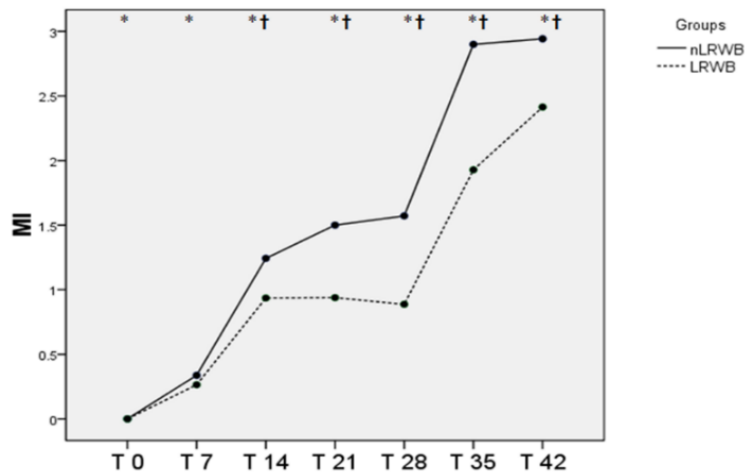
Figure 8. Differences in morphological index (mean) measured in nLRWB and LRWB units, during the storage period. The days of storage are presented in the x-axis. MI is presented in the y-axis. Asterisks * p < 0.05.